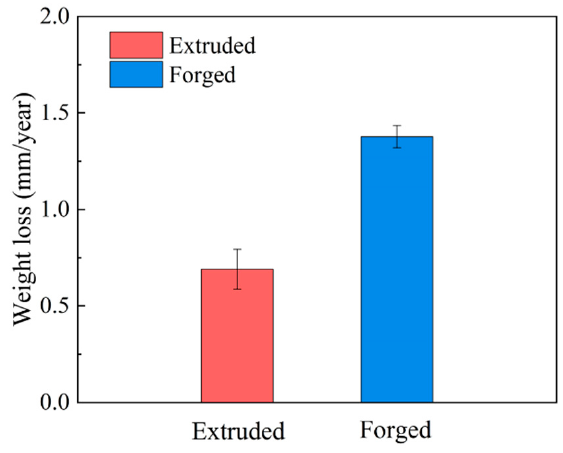
Figure 8. Weight loss rates of WE43 alloys after immersion in 0.6 M NaCl solution for 7 days.